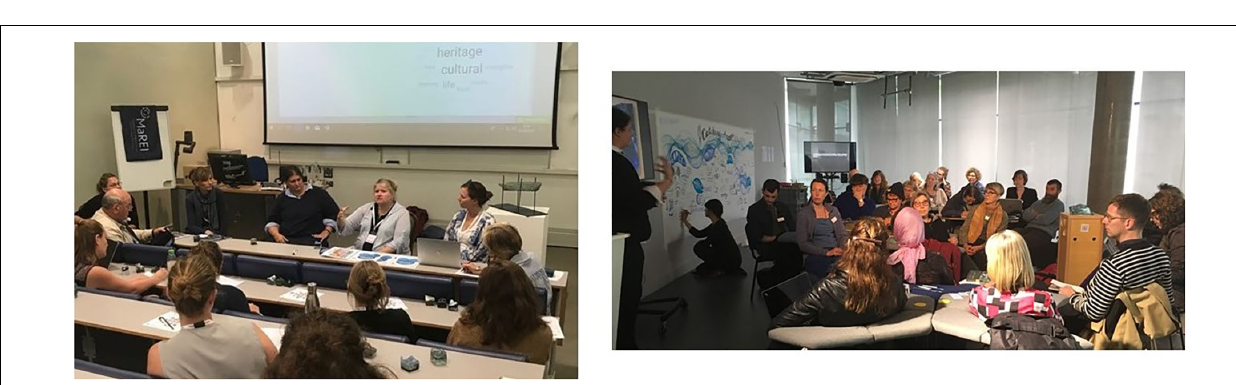
to become part of the conversation between specific